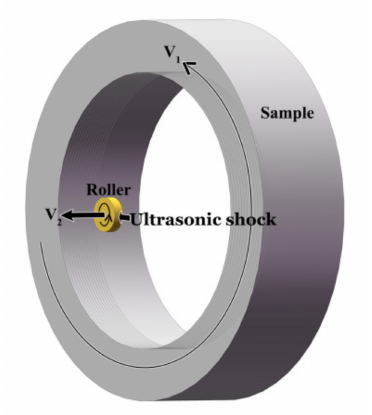
Figure 1. Schematic illustration of the USRT set-up.